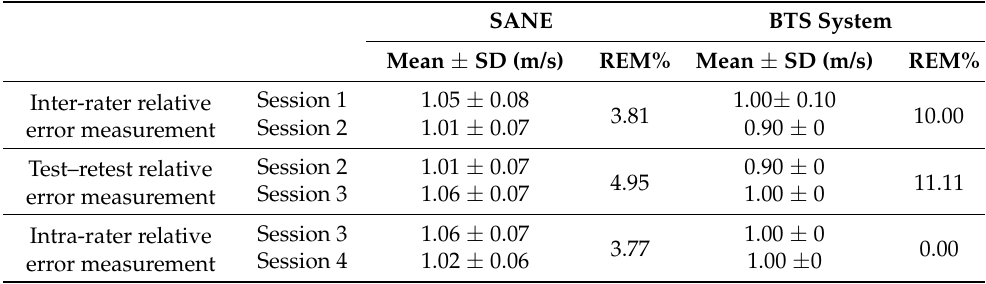
Table 8. Results for gait